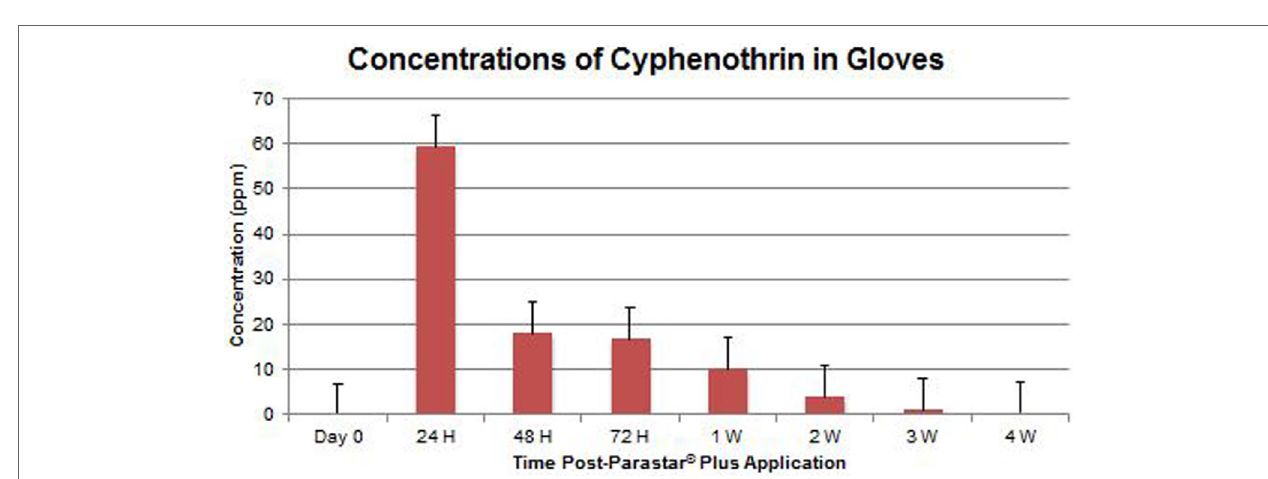
FigUre 5 | concentrations of cyphenothrin in gloves (mean ± seM) .